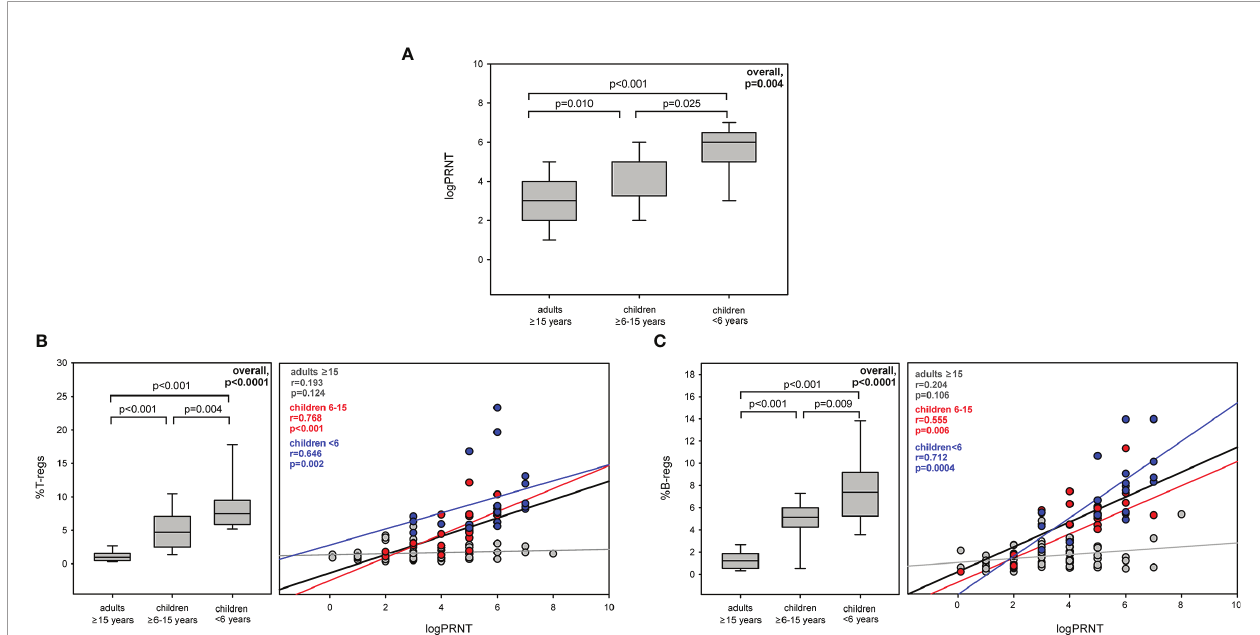
FIGURE 3 | Levels and relationship between Tregs and Bregs with PRNT at second sampling. Levels of PRNT (A) , Tregs (B) , and Bregs (C) in COVID-19 subjects among age classes and the relationship of these immunological markers with PRNT values at 6.1 (5.3 – 7.2) months after